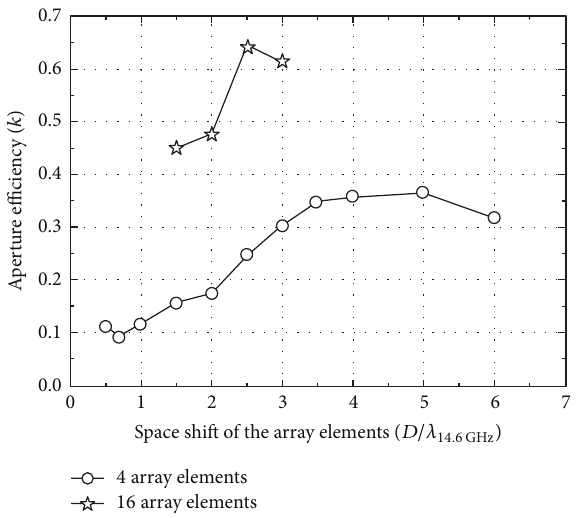
Figure 9: Aperture efficiency and element spacing of the two MTMs-cover